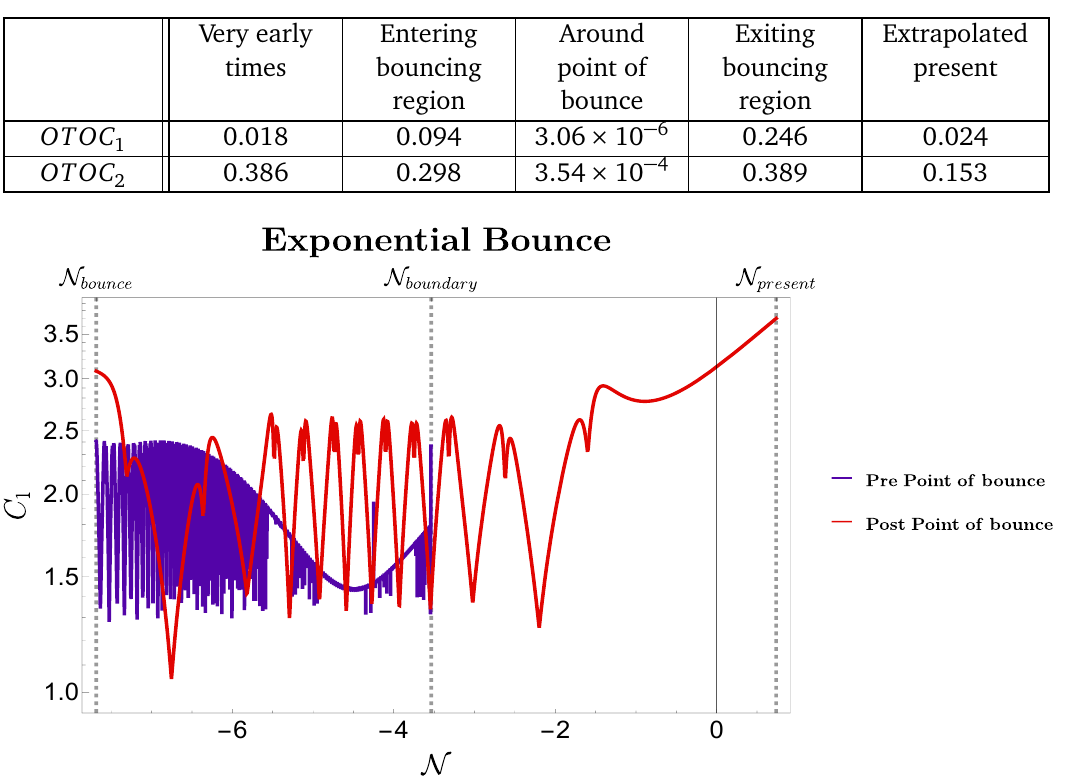
Table 8: Predicted OTOC values at different points of interest with respect to scale factor.